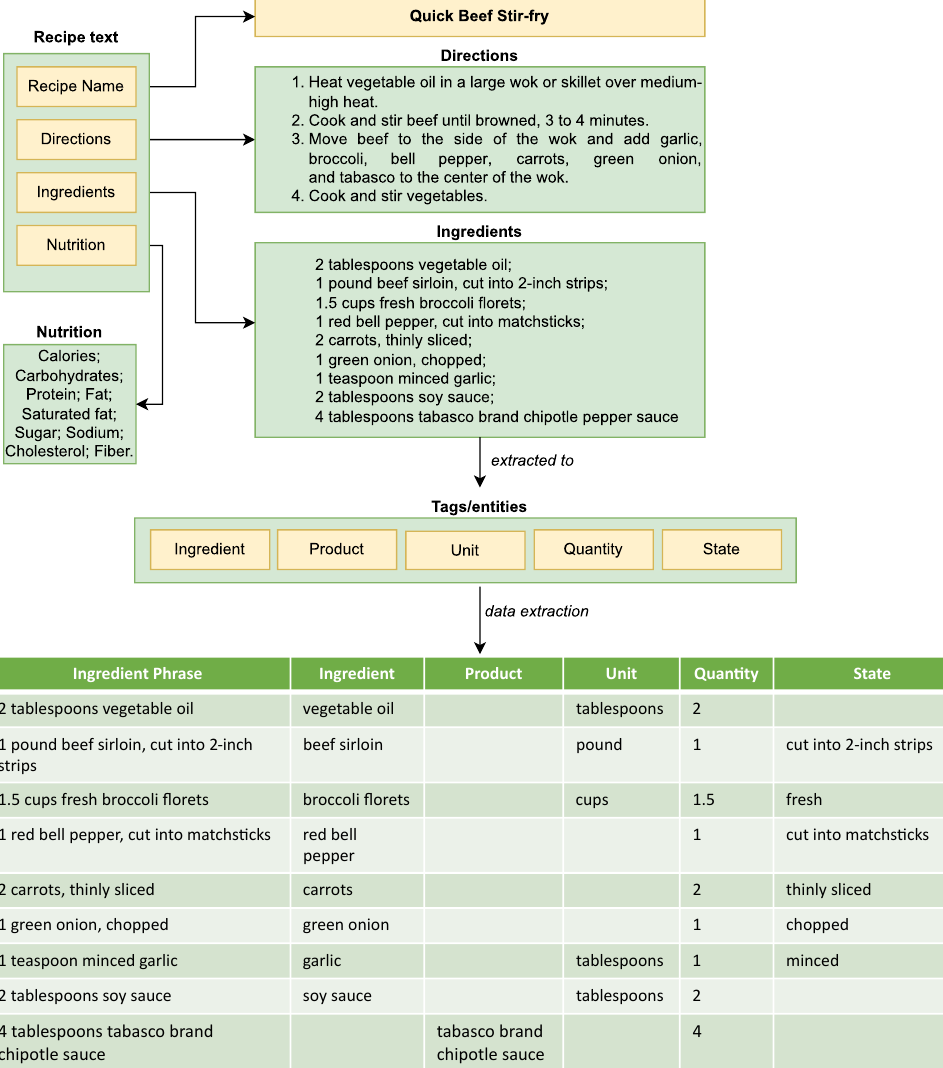
Figure 2. Ingredient data extraction from Allrecipes